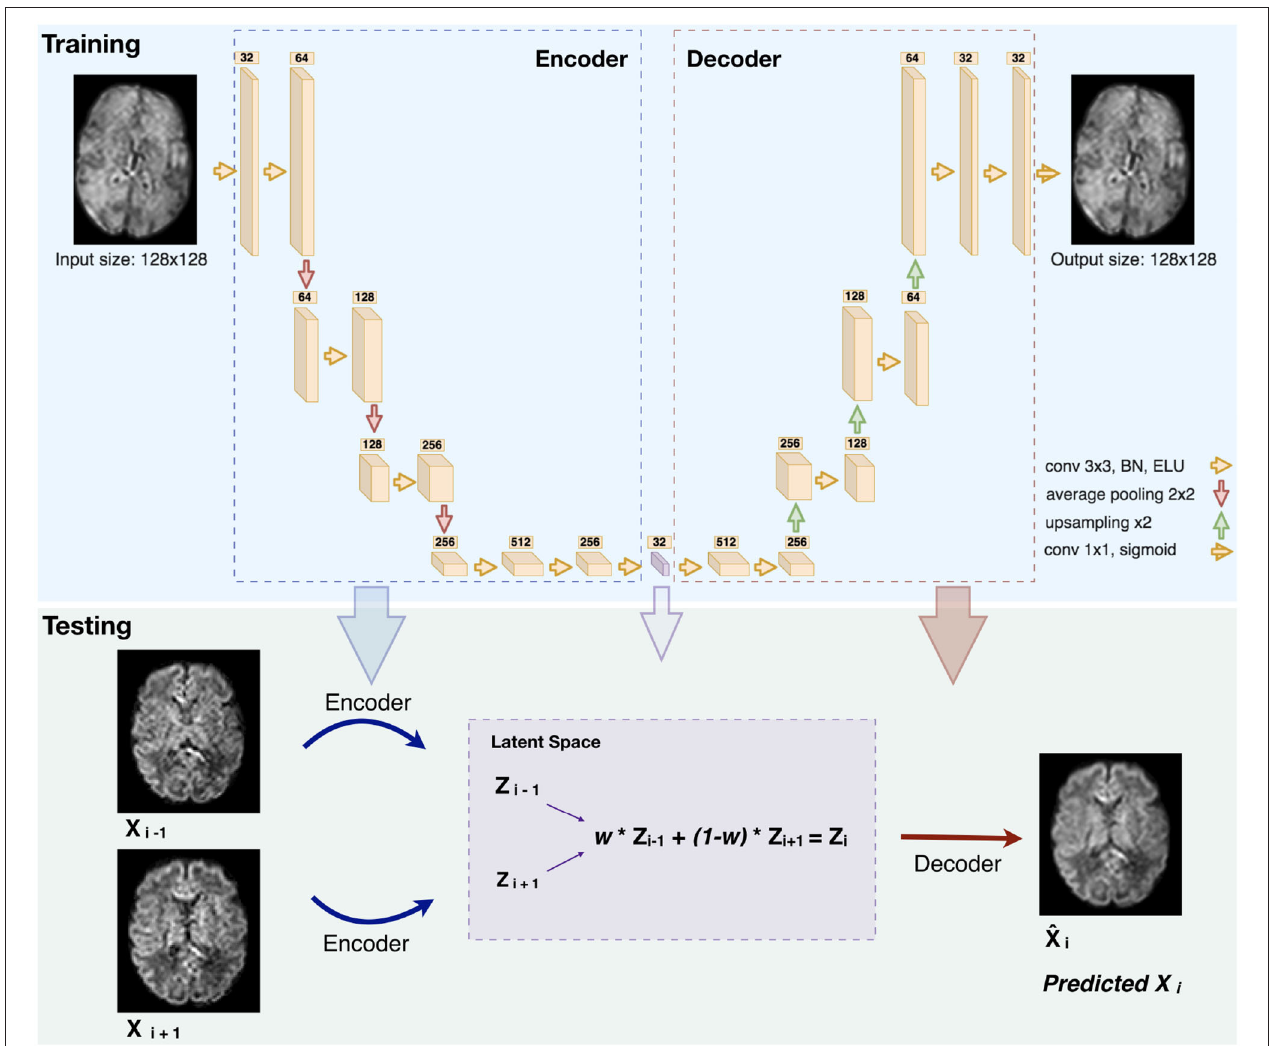
FIGURE 2 | Illustration of the network architecture (top): Each box is a multi-channel feature map. The number of channels is denoted on top of each box. The violet box represents the latent space of the autoencoder (BN: Batch Normalization. ELU: Exponential Linear Unit). An illustration of how we generated middle slice(s) is shown in the bottom panel (Testing), for the case of an equal slice weighting ( w = 0.5) and